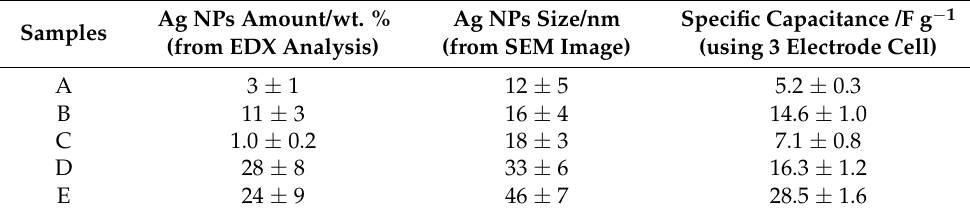
Table 1. Characteristics of the Ag NPs, particularly Ag NPs content, size, and specific capacitance of the different samples. Data from Brand ã o et al. [24]